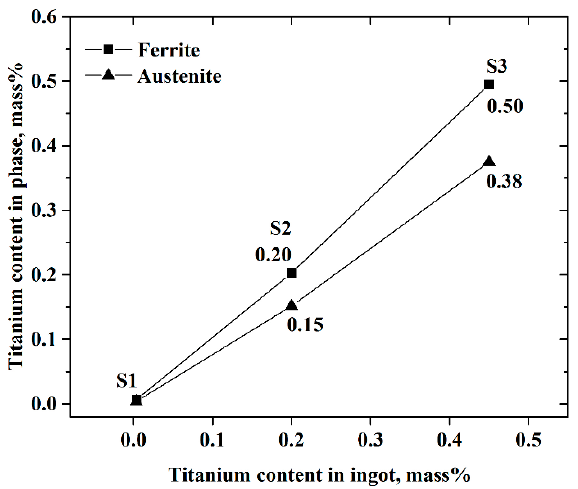
Figure 9. Titanium distribution in ferrite and austenite by electron probe (EPMA).